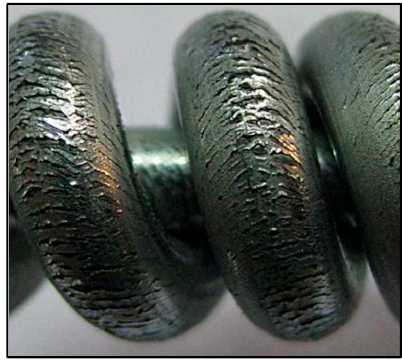
Figure 2. Circumferential cracks on steel wire after the torsion test.